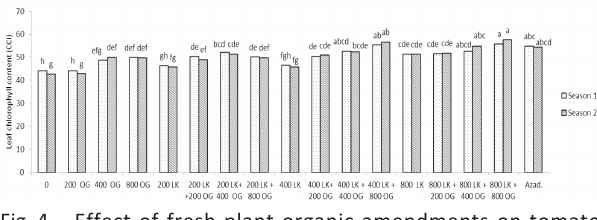
Fig. 4 ­ Effect of fresh plant organic amendments on tomato plant chlorophyll content taken after two week interval. Means followed by the same letter in a letter series within a column per season are not significantly different according to Tukey’s honestly significant difference (THSD) at P≤0.05. OG = Ocimum gratissimum L. and LK = Lippia kituensis Vatke, are soil organic amendments in g/10 Kg soil, 0 = no amendment and AZAD = positive con­ trol of commercially know pesticide Azadirachtin.